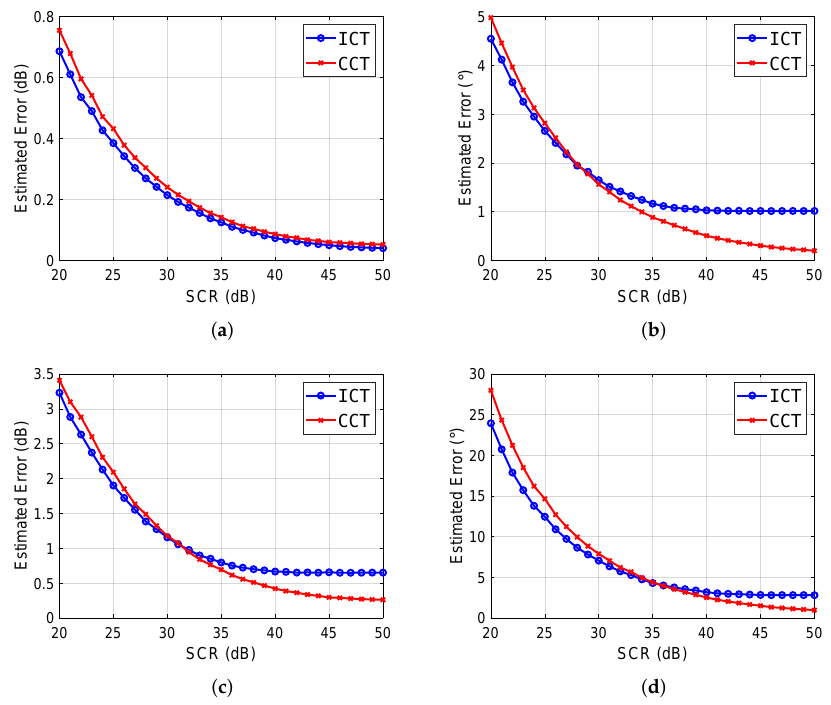
Figure 10. Simulation of distortion parameters estimation error with different SCR. ( a ) | f 1 | (dB). ( b ) arg { f 1 } ( ◦ ) . ( c ) | δ c | (dB). ( d ) arg { δ c } ( ◦ ) .